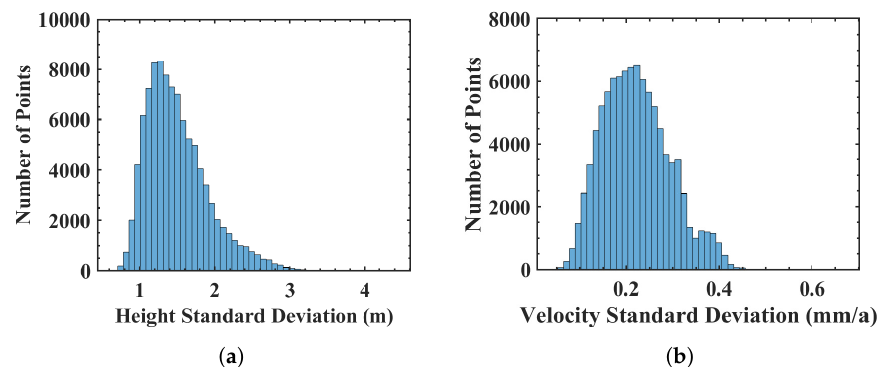
Figure 3. Histograms of the precision: ( a ) height; and ( b ) deformation velocity.